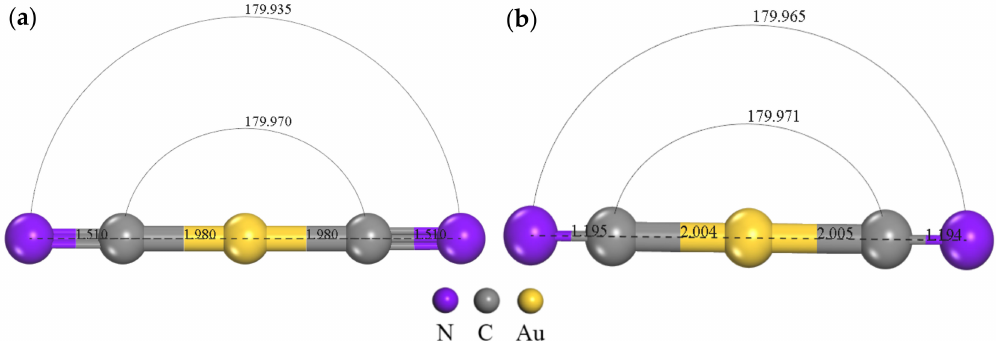
Figure 3. [Au(CN) 2 ] − configuration: ( a ) before optimization, ( b ) after